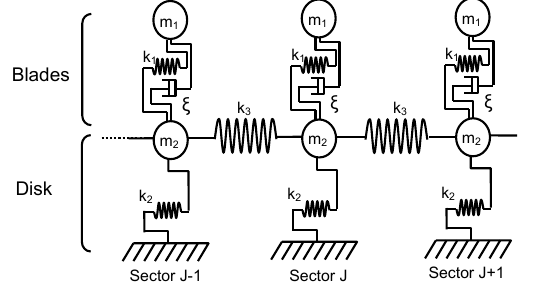
Fig. 1 Two degrees of freedom per sector